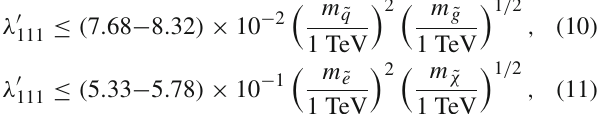
Fig. 10 Distribution of the summed electron energies in the ββ chan- nel and the ratio between the observed and MC predicted data. The inset plot shows the highest energy events on a linear scale. The solid his- tograms represent the backgrounds and 2 νββ predictions and the open histogram shows a hypothetical 0 νββ signal corresponding to the limit